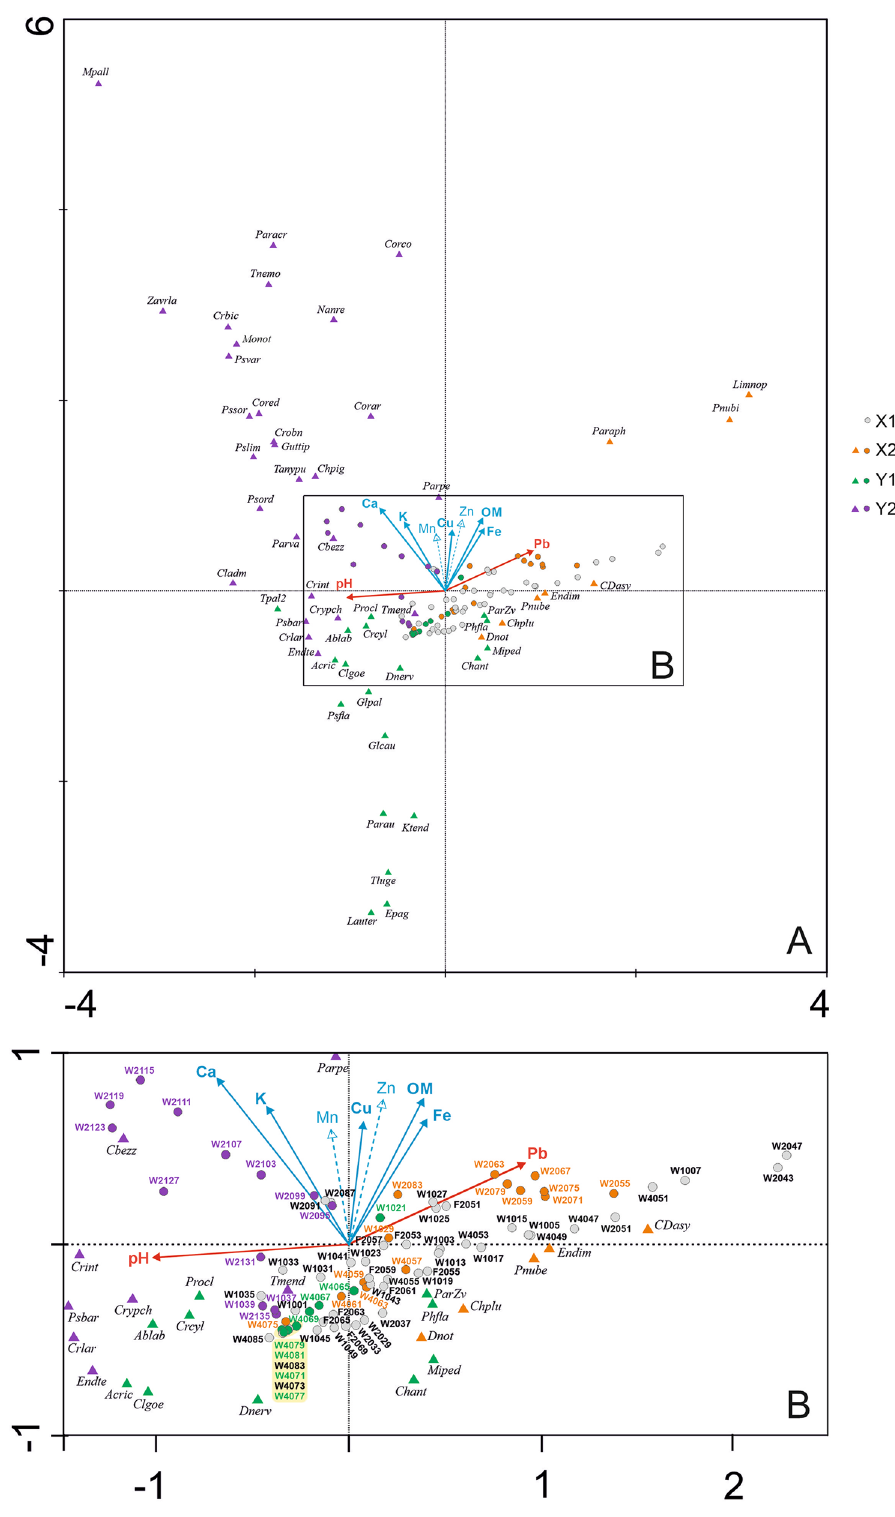
Figure 5. CCA biplot showing changes in the moat states expressed by SOM subclusters represented by indicative dipteran taxa (triangles) and sediment samples (circles), under a gradient of environmental variables ( A ). Variables correlated with Ax1 are shown as red arrows, while those correlated with Ax2 are shown as blue arrows. Mn and Zn were not significant for the analysis. Taxa and samples associated with each subcluster are coloured differently. Sample codes given on zoom ( B ) are arranged as follows: first two signs stand for core symbol (W1—RP W1, W2—RP W3(2), W4—RP W3(4), F2—RP F2), followed by numbers referring to depth (in cm b.g.l.). For full names of taxa see Supplementary Table